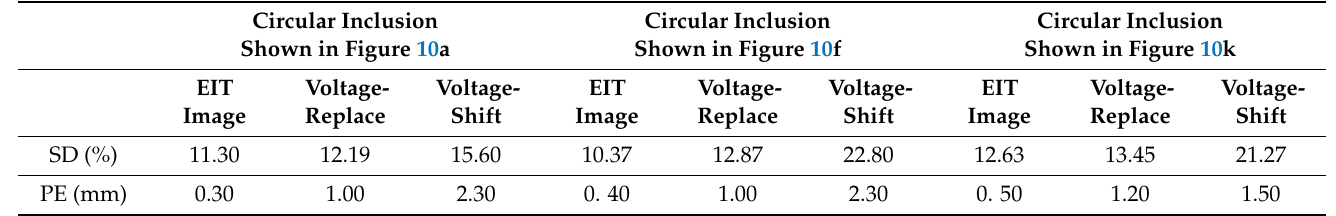
Table 1. Shape deformation (SD) and position error (PE) of the EIT images obtained with simulation, as shown in Figure